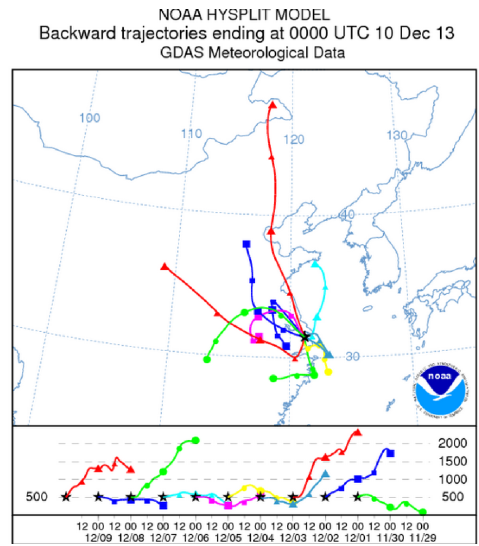
Figure 10. Air mass 48h backward trajectories arriving at Shanghai from 1 to 10 December 2013. A new trajectory is started at 00:00 (UTC) and calculated every